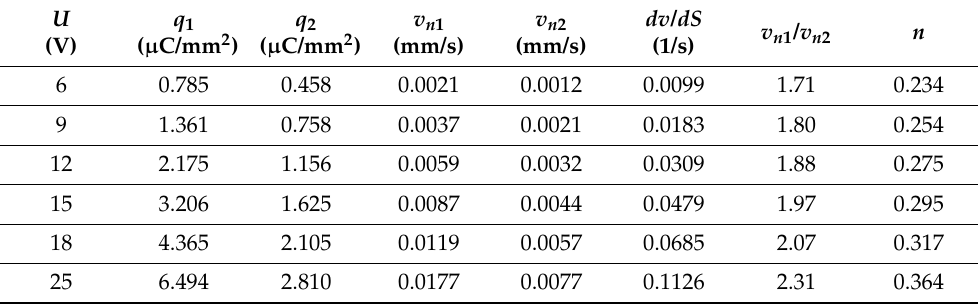
Table 1. Summary of calculations performed on the basis of the equation q ( S , U = const ) for 5%